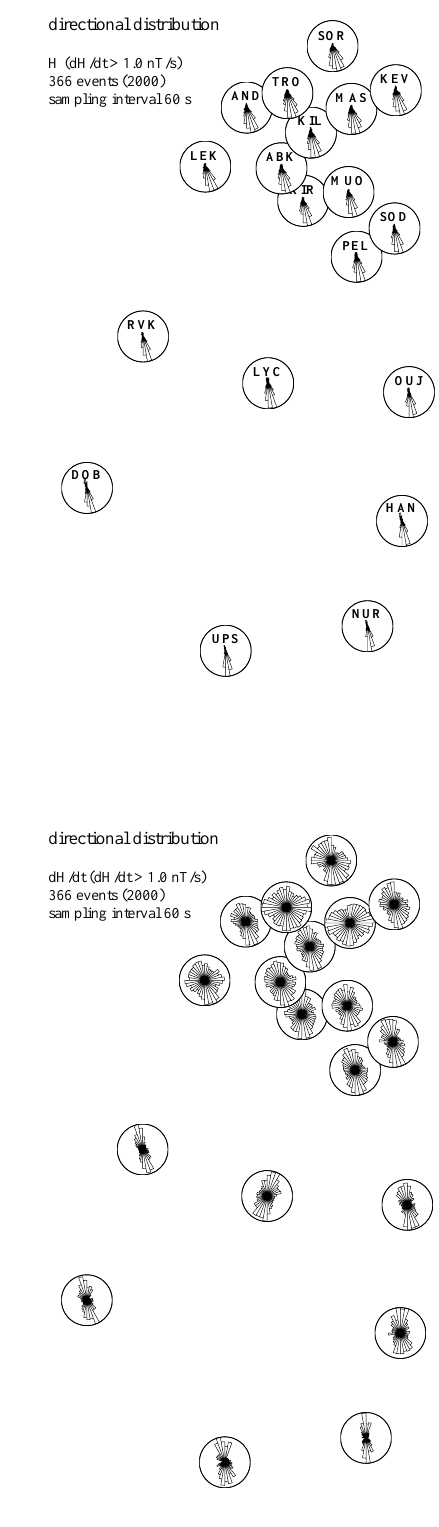
Fig. 6. Directional distributions of ∆ H and d H /dt at the conti- nental IMAGE stations in 2000 (from one-minute values with the condition | d H /dt | > 1